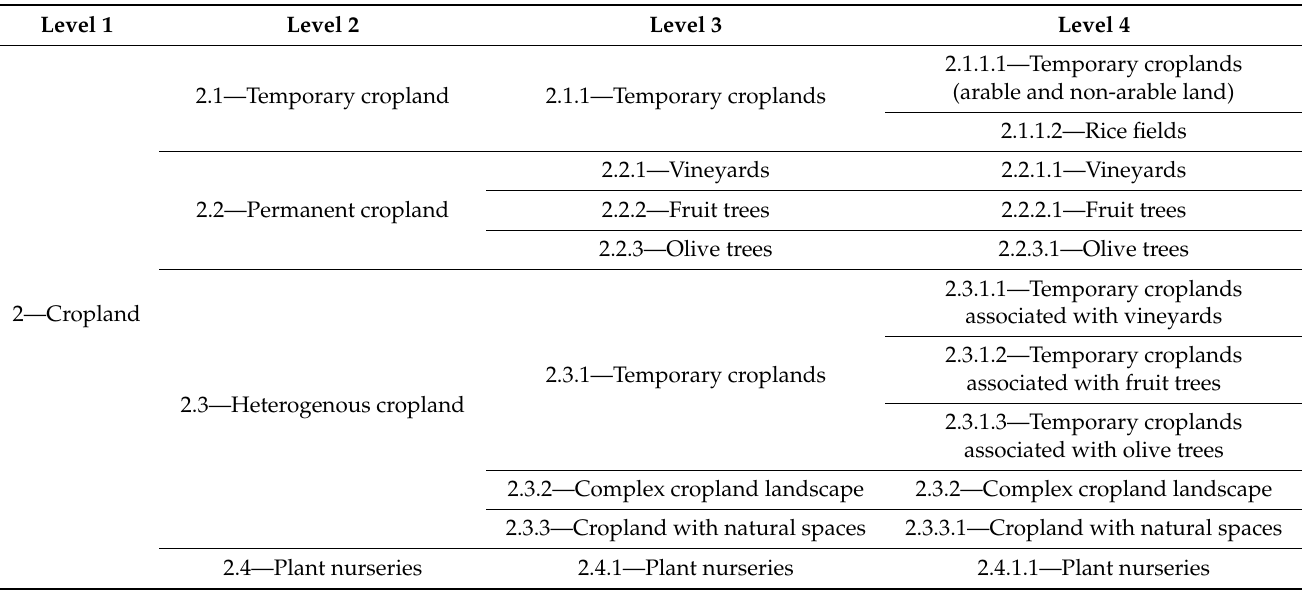
Table 1. Example of class subdivision of class 2 (Croplands) in COS18. The remainder of the extensive nomenclature can be seen on page 15 in